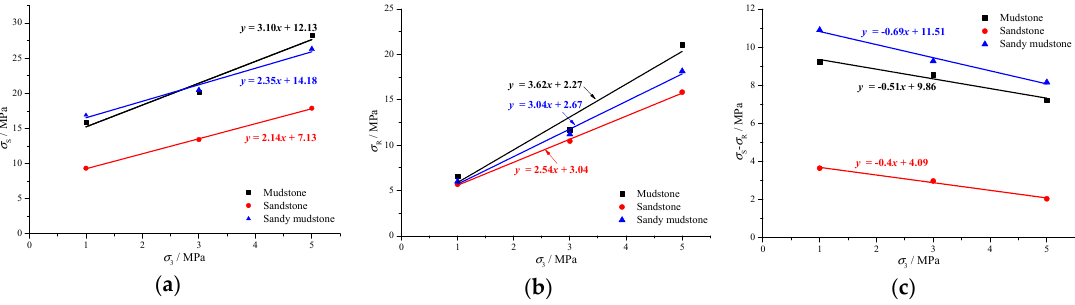
Figure 7. E ff ects of confining pressure on the mechanics behaviors of rock samples. ( a ) Peak stress; Figure 7. Effects of confining pressure on the mechanics behaviors of rock samples . ( a ) Peak ( b ) residual stress; ( c ) di ff erence between peak stress and residual stress; ( b ) residual stress; ( c ) difference between peak stress and residual stress.